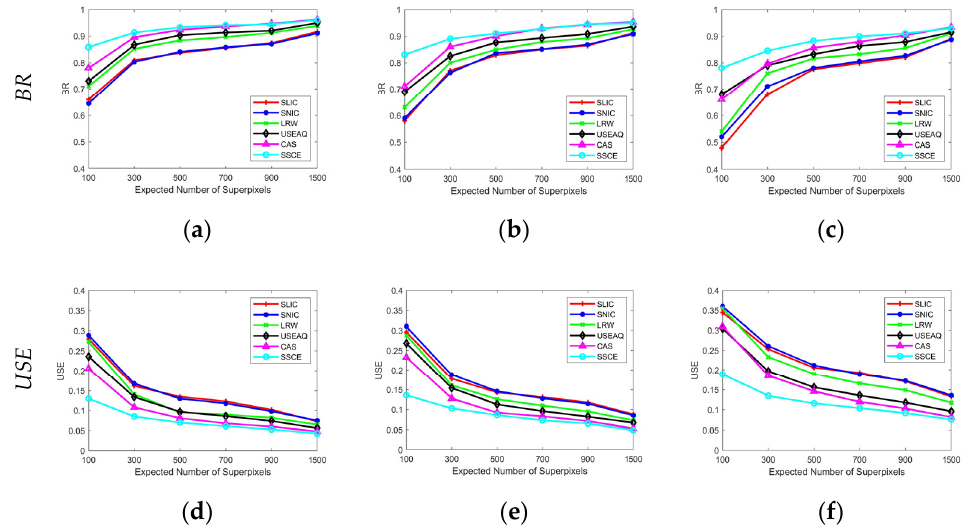
Figure 10. Quantitative evaluation of other superpixel segmentation algorithms and the proposed SSCE: ( a – c ) BR curves; ( d – f ) USE curves of self-built dataset, BSD500 and 3Dircadb, respectively.